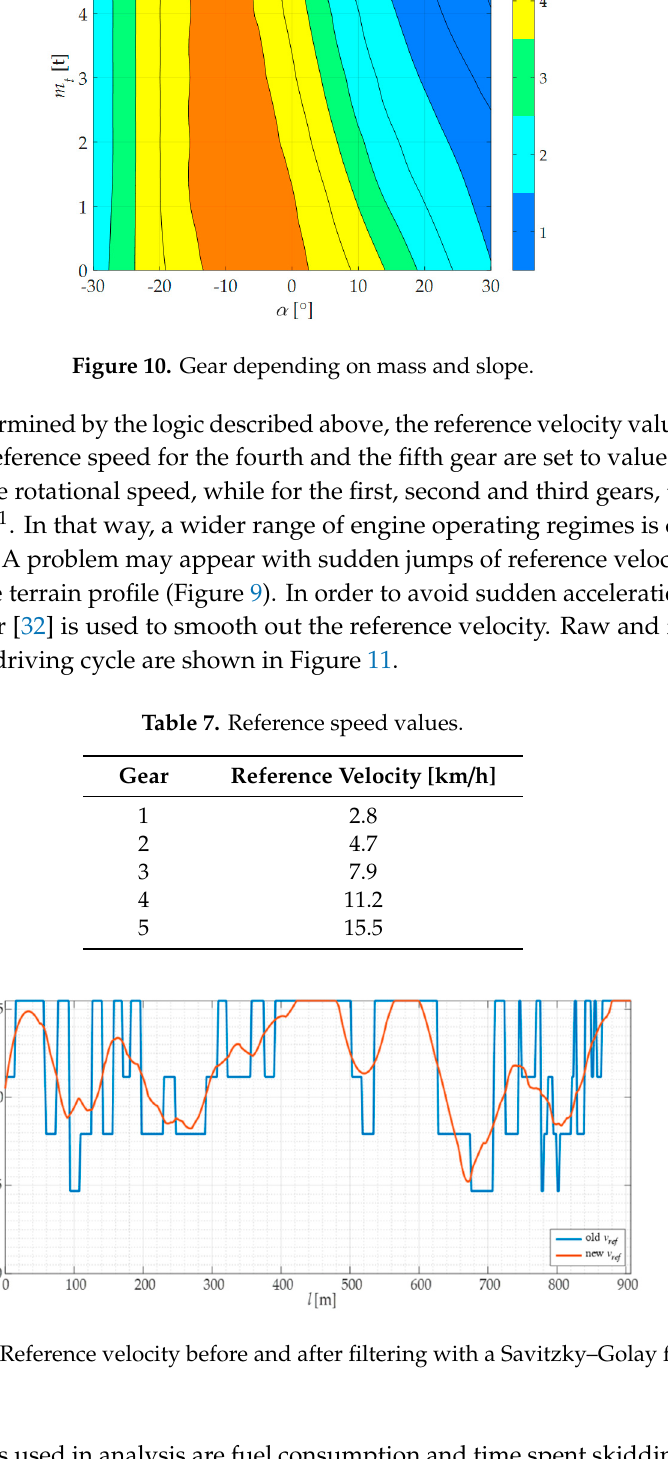
Figure 12. Velocities and slope for one driving scenario and driver commands. Figure 13. Engine speed and torque of conventional skidder for one driving scenario.